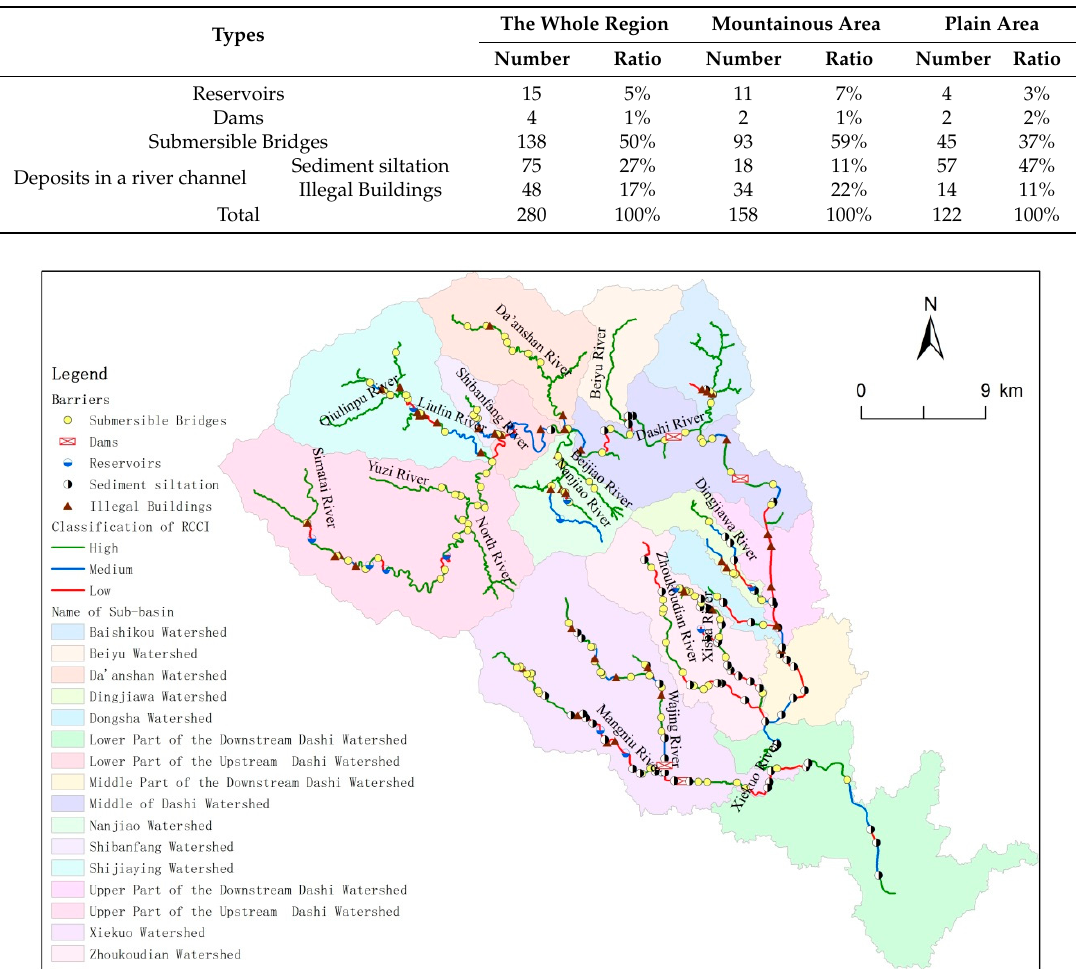
Figure 5. RCCI assessment results for segments.